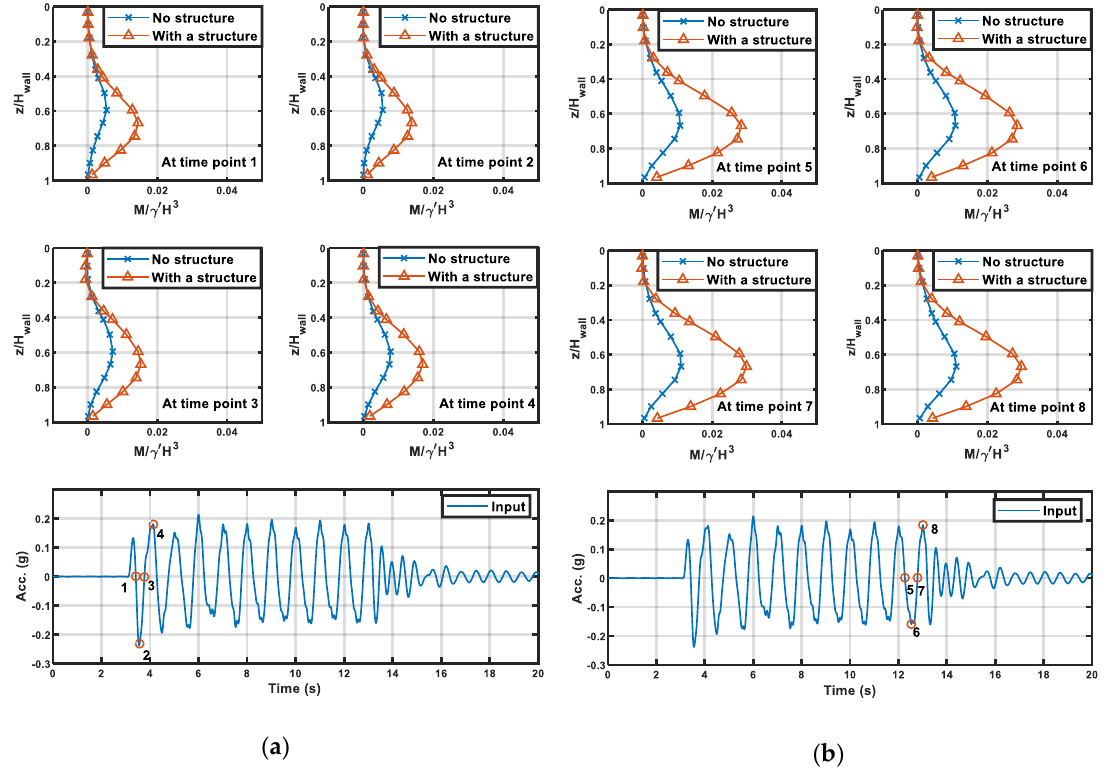
Figure 10. Dynamic bending moment profiles at different time instants: ( a ) during an earlier cycle and ( b ) during a later cycle.